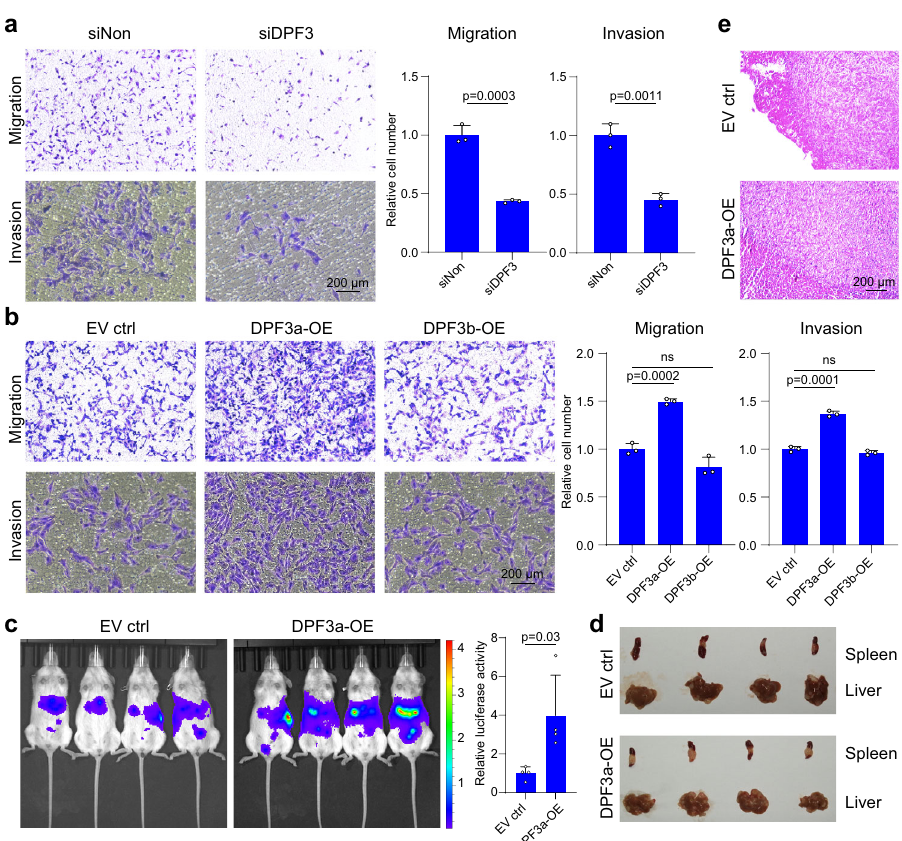
Fig.2|DPF3apromotedcellmigrationinvitroandinvivo.a The migration and invasion ability of primary ccRCC cells with or without DPF3 knockdown was measured using the Transwell assay. Cells were seeded on top of the membrane and fi xed and stained with crystal violet after 24h incubation. Cell numbers on the bottom of the membrane were quanti fi ed and statistical signi fi cance was estimated using a two-sided student t -test. Data were presented as mean values±SD ( n =3 independent experiments). Scale bar, 200 μ m. b The migra- tion and invasion ability of 786-O cells with or without DPF3a/b overexpression was measuredusingTranswellassay.Cellswereseeded on top ofthe membrane and fi xed and stained with crystal violet after 24h incubation. Cell numbers on the bottom of the membrane were quanti fi ed and statistical signi fi cance was